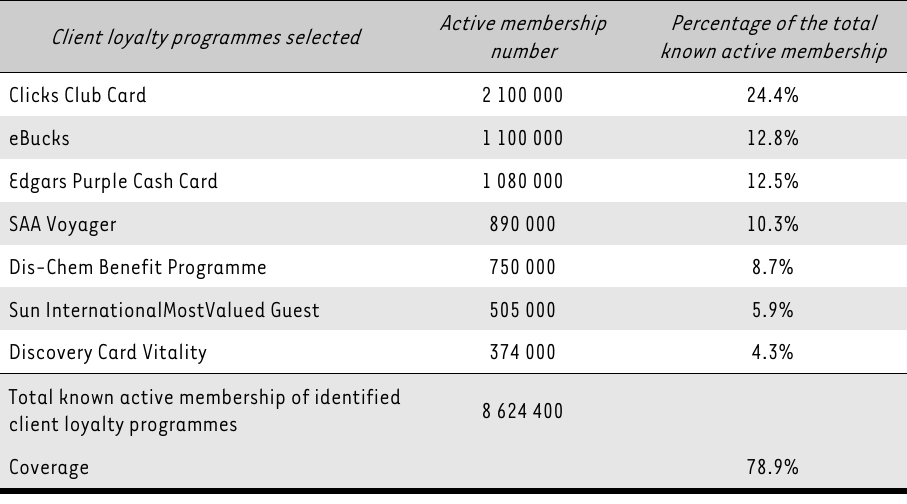
TABLE 1: Selection of client loyalty programmes, active membership number per programme and the percentage of the total known active membership Client loyalty programmes